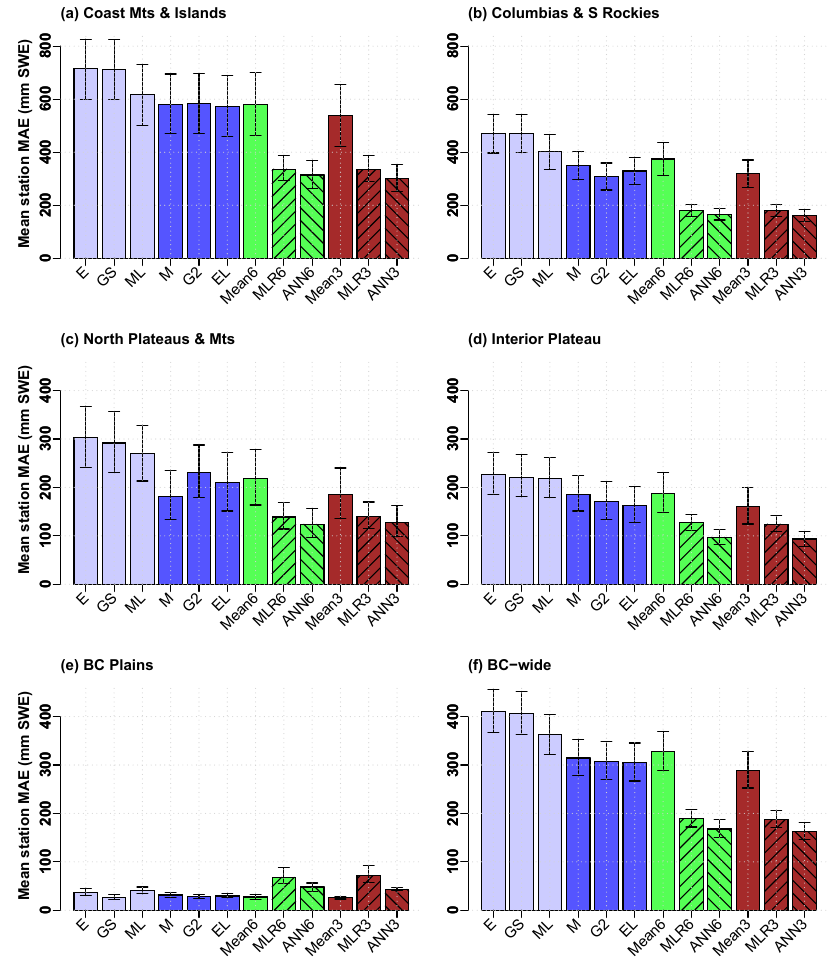
Figure 4. Mean station MAE for several SWE products/combinations for regions of BC in order of descending mean accumulations: (a) Coast Mountains and Islands, (b) Columbia Mountains and Southern Rockies, (c) Northern Plateaus and Mountains, (d) Interior Plateau, (e) BC Plains, and (f) province-wide (combining all data from the five preceding panels). Shown are MAEs with 95% confidence intervals based on n = 5000 bootstrap samples for the six gridded products in blue: ERA-Interim (E), GlobSnow (GS), MERRALand (ML), MERRA (M), GLDAS2 (G2), and ERALand (EL). Dark blue indicates three best-performing products. Also shown are three fusion techniques (mean, MLR, and ANN) using all six products (green) and the three best-performing products (brown). Note the vertical scale in panels (a) and (b) is double that of panels (c) through (f)